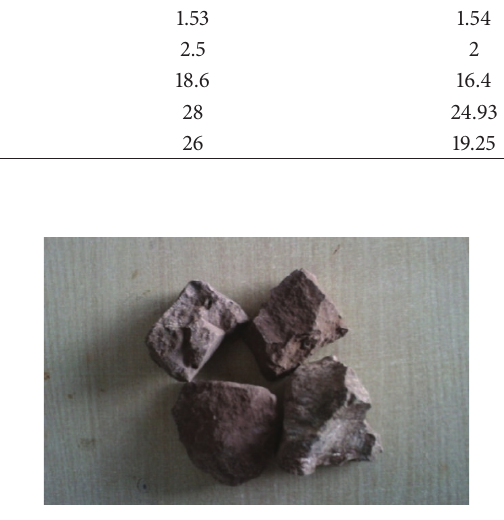
Figure 1: EAF oxidizing